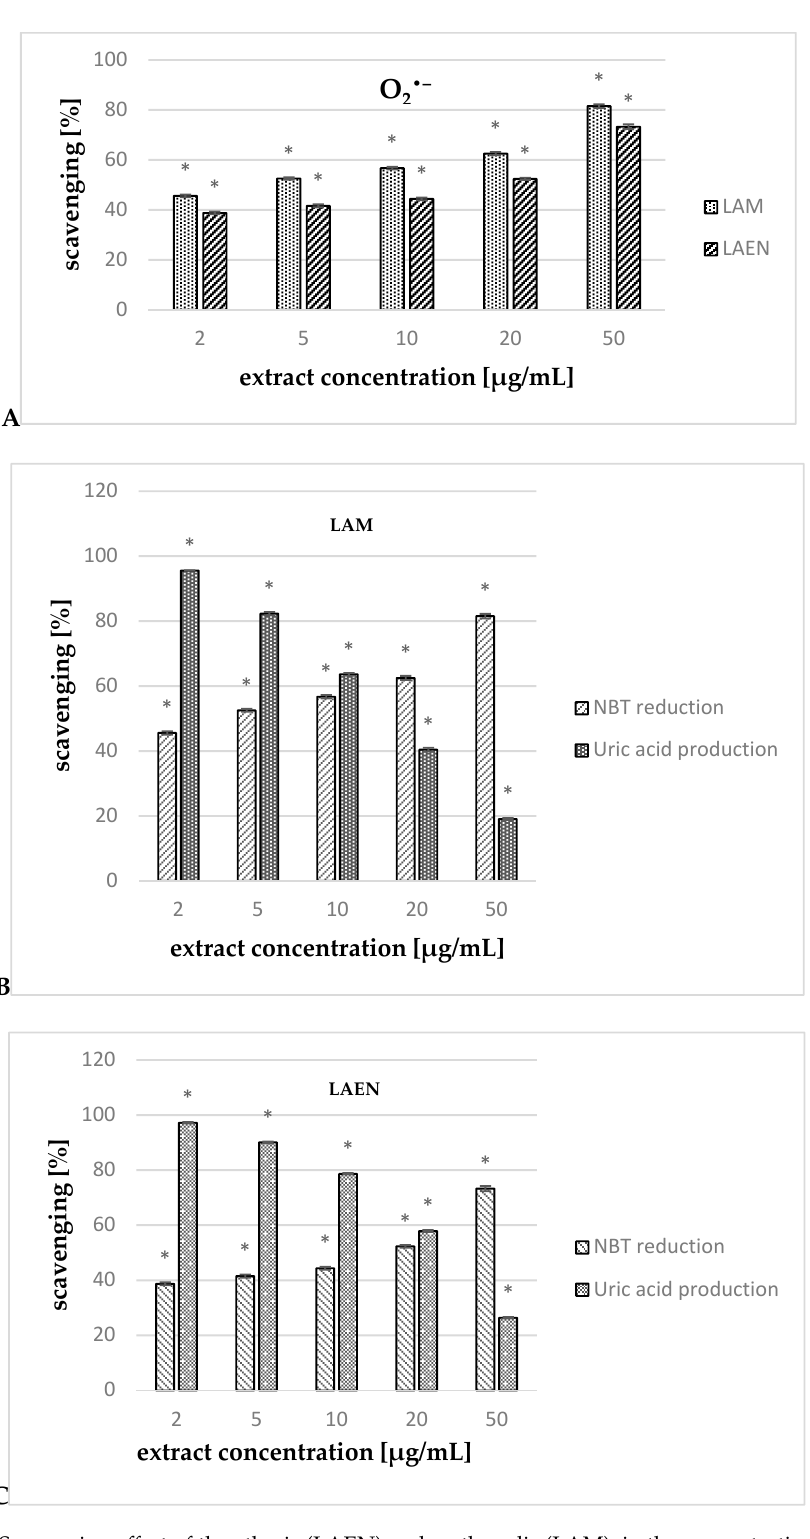
Figure 9. Scavenging effect of the etheric (LAEN) and methanolic (LAM), in the concentration range of 2 to 50 μ g/mL, on O 2• − scavenging [%] in the xanthine/xanthine oxidase system ( A ). Effects of the LAM ( B ) and LAEN ( C ) on the xanthine/xanthine oxidase system [%]: nitrobluetetrazolium (NBT) reduction determines the scavenging of O 2• − ; uric acid production determines the oxidase inhibition. Statistical significance of differences was calculated between both extracts or between uric acid production and NBT reduction; * p < 0.05.